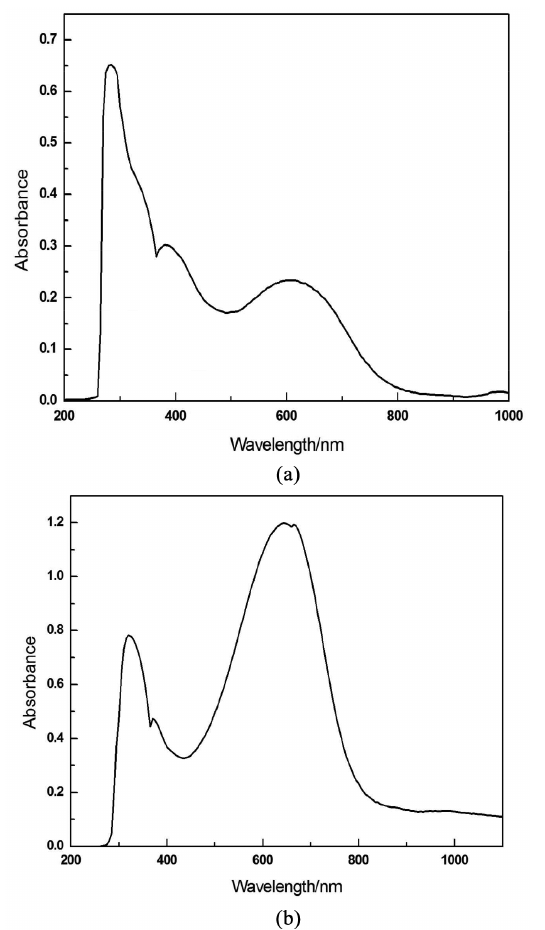
Figure 1. UV-Visible spectra of (a) pure PANI (b) PANI composite.